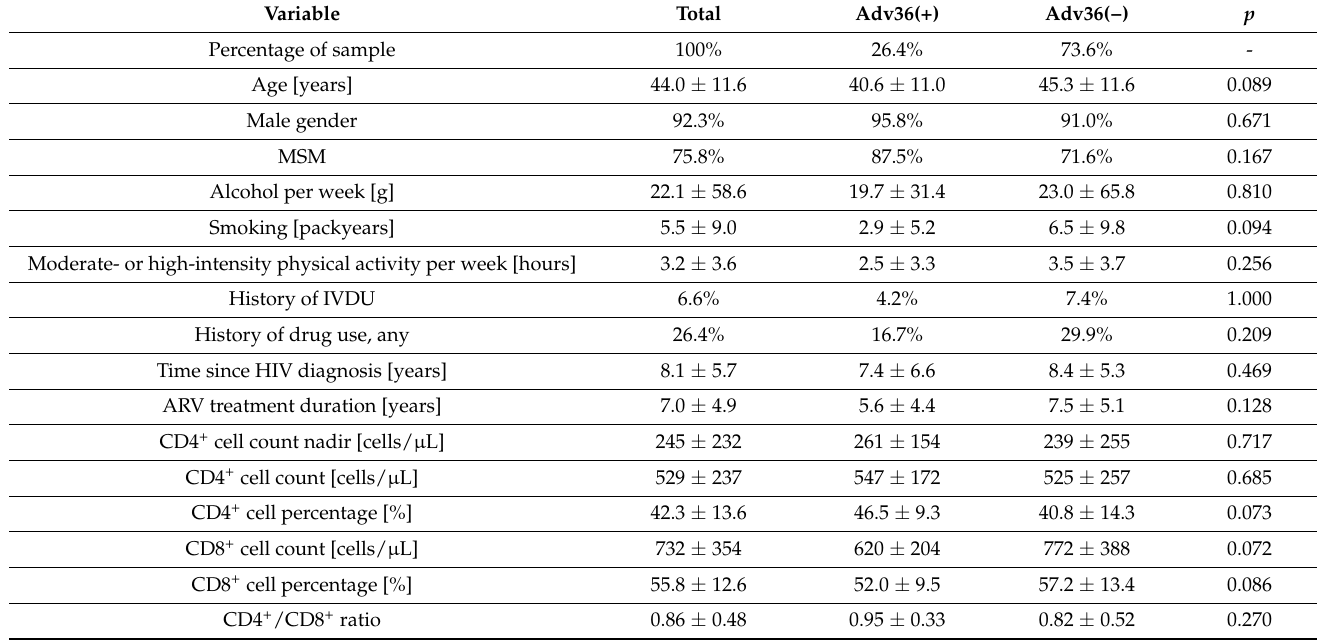
Table 1. Laboratory and biomarker levels according to Adv36-serostatus—univariate analysis. Results of qualitative variables shown as percentages; results of quantitative variables shown as mean ± standard